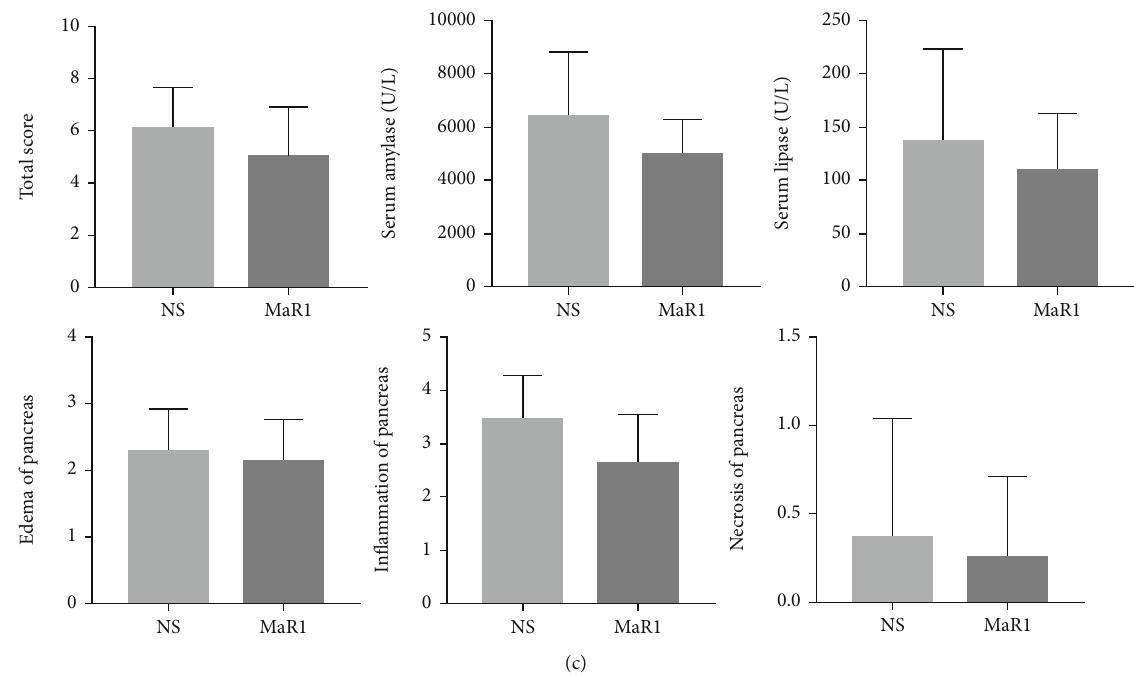
Figure 4: MaR1 did not further protect against AP after pancreatic macrophages clearance. (a) Flow cytometry of macrophages ratio changes in blood samples after CL injection. (b) Representative pathological changes in the pancreas after caerulein challenges. HE-stained sections of the pancreas in magni fi cation 100x and 200x. (c) Histological scores of pancreatic tissues (edema, in fl ammation, and necrosis) and serum levels of amylase and lipase. n = 7 each